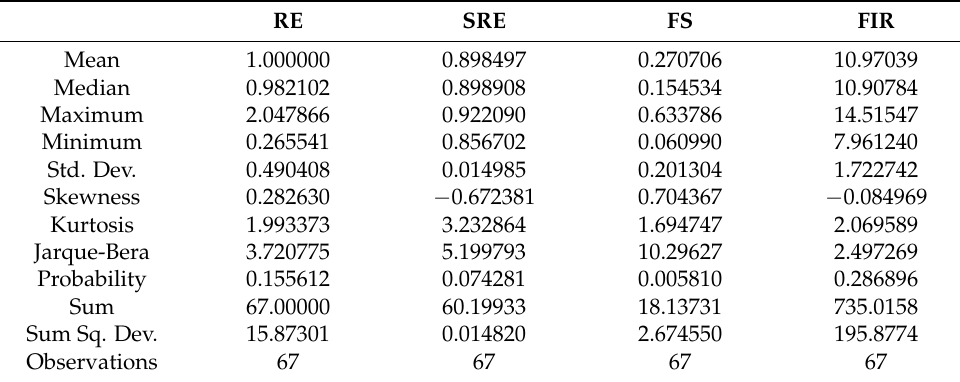
Table 4. Descriptive statistical results. Source: Own calculation.